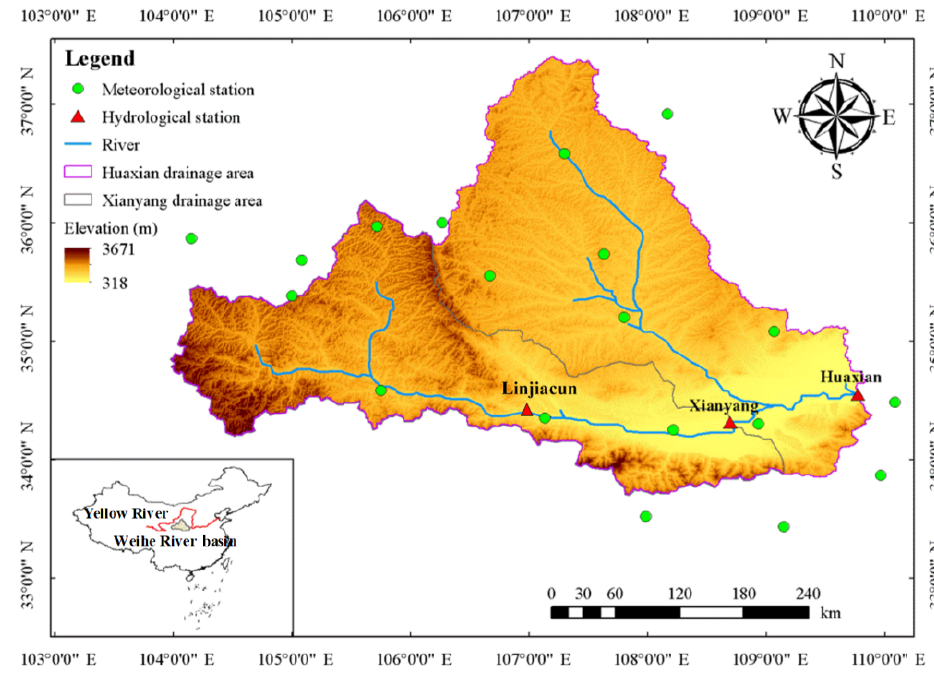
Figure 2. Location, topography, hydro-meteorological stations and river systems of the Weihe River basin. Table 3. The summary of candidate explanatory variables and reason of